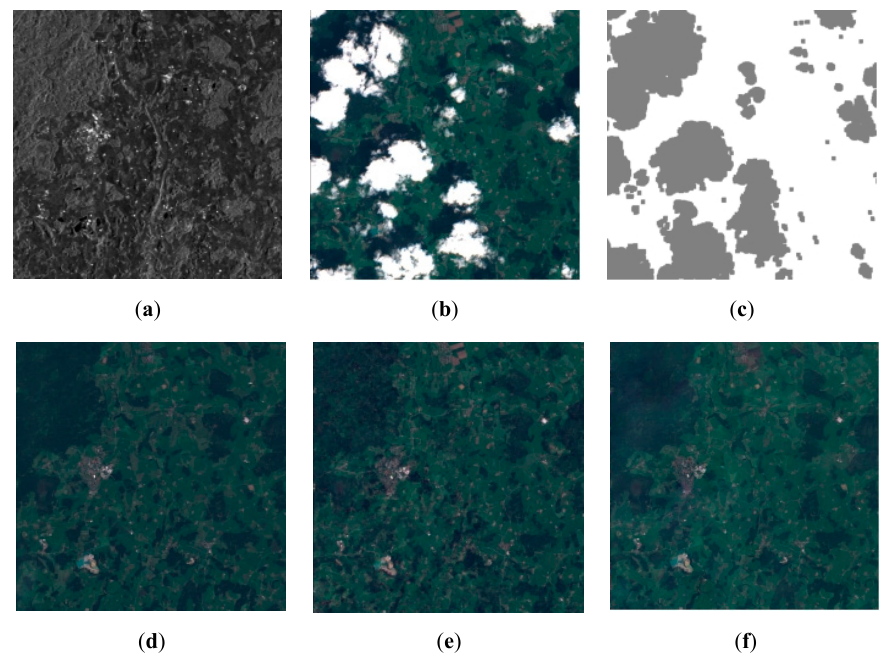
Figure 6. Overview of the results of the real experiment. ( a ) Original SAR image; ( b ) corrupted optical image; ( c ) cloud mask and ( d ) pix2pix model. ( e ) SAR-opt-GAN model; ( f ) the proposed model.